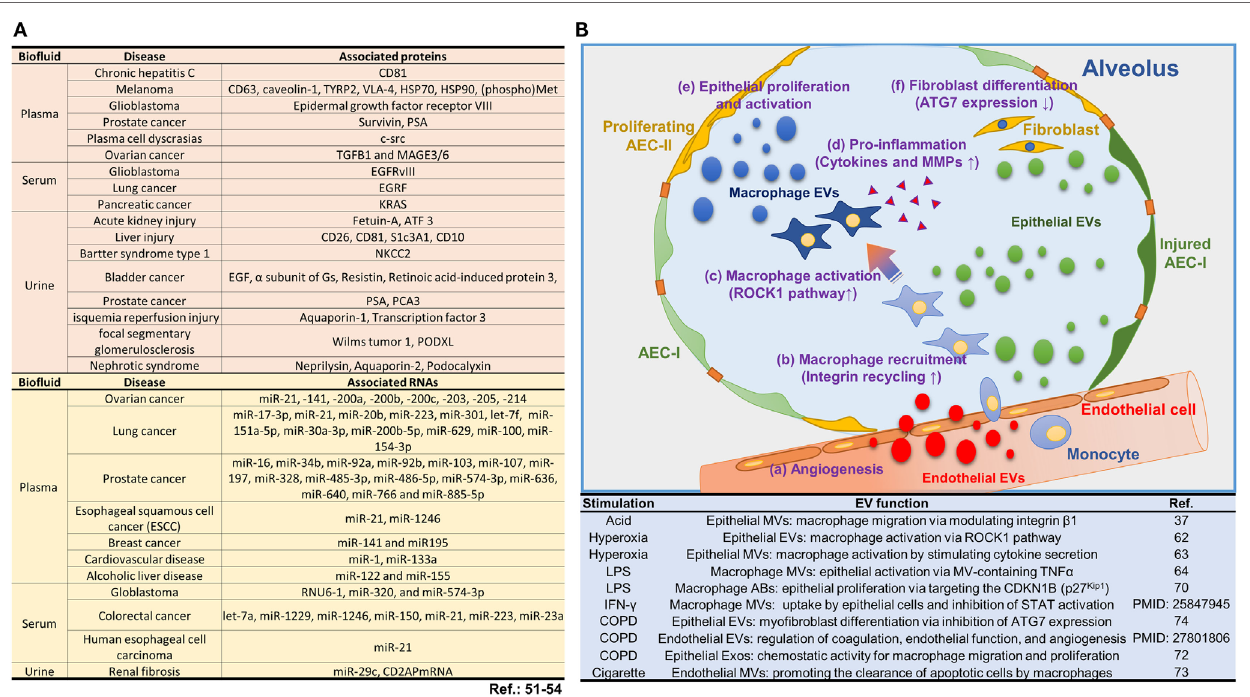
FiGURe 2 | Roles of extracellular vesicles (EVs) in lung injury. (A) EV-containing molecules reported to potentially serve as biomarkers. (B) The current reports on EVs and their functions involved in lung injury and inflammation. Schematic illustration and the summarized table for the biological pathways by which EVs contribute to the alveolar inflammatory